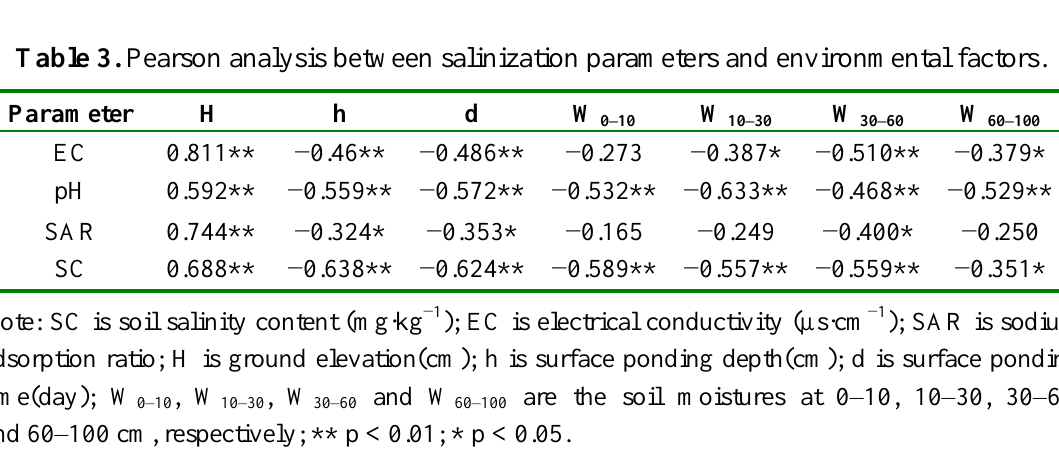
Table 4. Regression model between salinization parameters and environmental factors. Regression